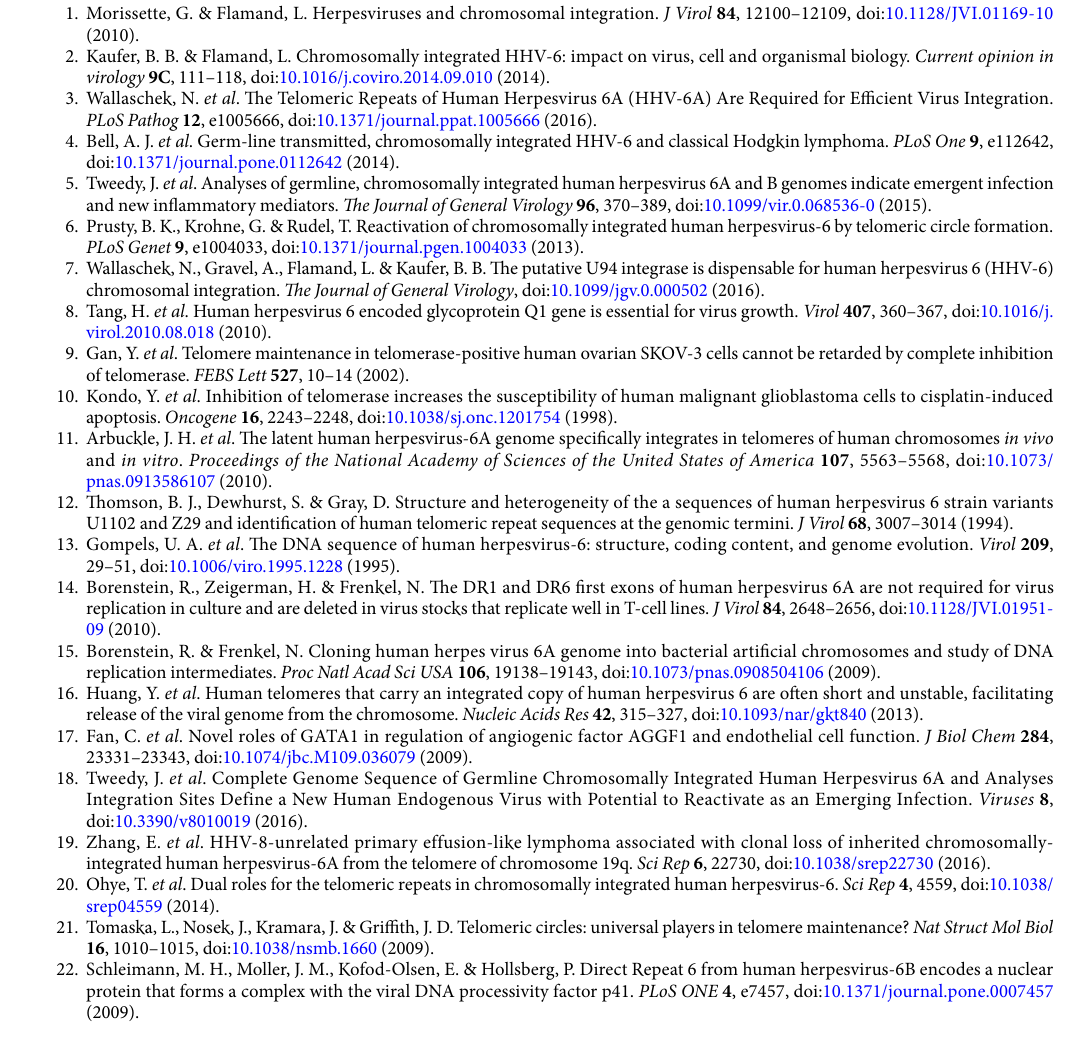
30 cycles. Primer details for iPCR are provided in supplementary Table S3. Amplified PCR products were purified using phenol:chloroform DNA extraction method and were run on a 1% agarose gel and processed for Southern hybridisation as described above. After cloning into the TOPO pCR 2.1 vector, amplicons were sequenced by the Sanger method, using M13 forward and reverse primers (Seqlab GmbH, Germany). In several cases, purified PCR products were directly sequenced without subsequent cloning. Generation of clonal population of cells using Flow cytometry. Different cells were infected with BAC derived HHV-6A (U1102) at an MOI of 5. 24 hrs post infection cells were sorted on an FACS ARIA III cell sorter (BD Biosciences, Germany) and GFP positive (virus infected) single cells were collected onto 96-well plates. Clonal population of cells were grown for 10 passages after which total cellular DNA was extracted for qPCR analysis. Some of these single cell derived clones were further grown for 50–100 passages to study viral genome stability. Fluorescence in situ hybridisation (FISH) for detection of integrated viral genome. FISH anal- ysis of viral DNA was carried out using previously described protocol 6 . HHV-6 non-DR specific FISH probes were generated by mixing purified PCR products from several different ORFs of the viral genome using prim- ers described in this manuscript 8 and PromoFluor-550 Nick Translation Labelling Kit (PromoKine, Cat. No. PK-PF550-NTLK-10). HHV-6 viral DR specific probe was generated by the same kit using DR-PCR product amplified using 5 ′ -AGGAACAGACAGACGGCCAC-3 ′ and 5 ′ -CTCTGCGGGGATTCACGGAT-3 ′ primers. Statistical analysis. Statistical analysis was done by an interactive model in R package that uses two- way Analysis of Variance (ANOVA) with copy number as the response. Patient ID, Sampling year and location of viral sequence (DR or entire HHV-6) were taken as factors, wherever required. Normality of data distribution and goodness of fit was assumed by observing the Residuals and Q-Q plot. Tukey’s Honest Significance Differences (HSD) test was performed for determination of individual comparisons, which calculates adjusted